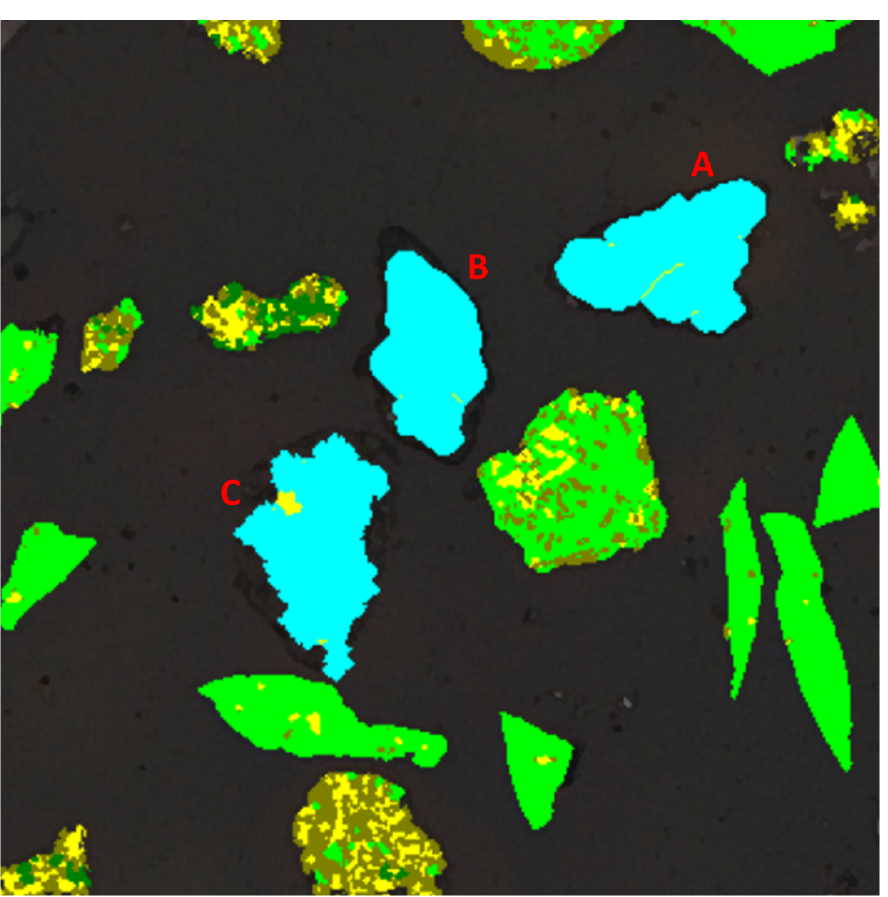
Figure 14. Final mineral identification for particles from Figure 2 (light green—vitreous goethite, brown—ochreous goethite, dark green—kaolinite, cyan—quartz, yellow—porosity). Quartz identification is border ‐ based for particles A and B, threshold ‐ based for particle C.